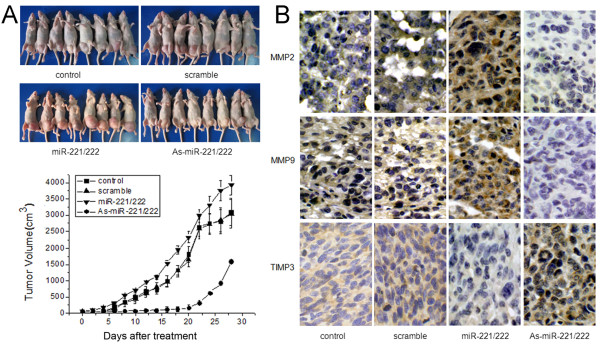
Effects of miR-221/222 on tumor growth in a xenograft mouse model. (A) After establishment of subcutaneous tumors, As-miR-221/222 and miR-221/222 were injected in a multi-site injection manner every 3 days for 15 days. Tumor volumes were measured every 2 days during treatment. (B) Expression of TIMP3, MMP2 and MMP9 was detected by immunohistochemistry in xenograft tumor sections.